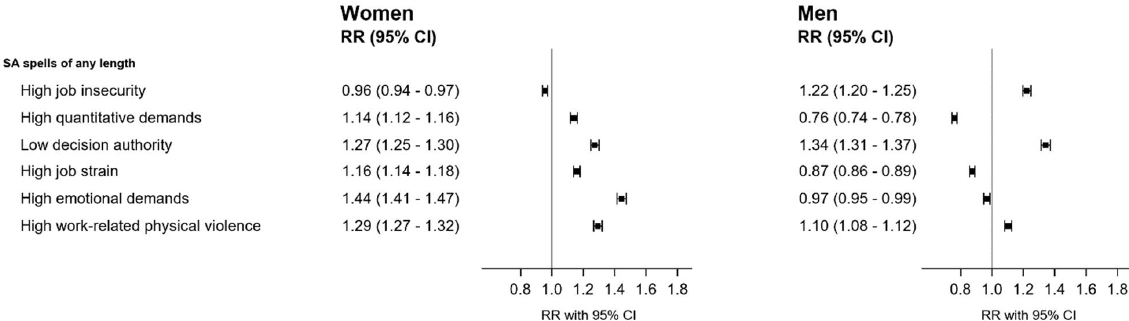
Figure 2. Fully adjusted rate ratio (RR) for the associations between being employed in occupations with specific psychosocial working conditions and sick - ness absence (SA) spells of any length (≥1 day) among women (N=160 104) and men (N=141 081). RR adjusted for age, migration background,